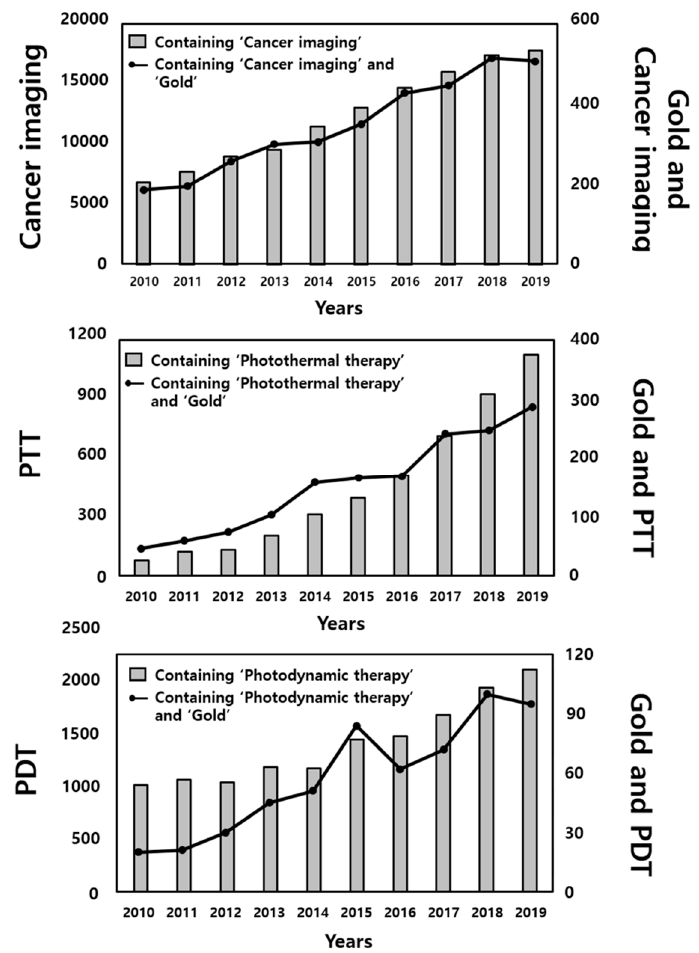
Figure 1. Numbers of recent publications featuring the terms gold and cancer imaging, photothermal treatment (PTT), or photodynamic therapy (PDT). Y-axes of graphs represent the numbers of published papers containing each of the indicated words. All values were obtained from PubMed.